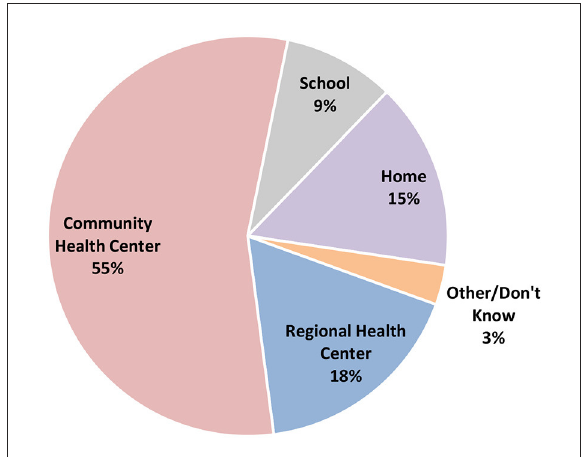
FIGURE6 Preference regarding location of HPV vaccination. Where would you want CC vaccination to take place? This pie chart shows the distribution of preferred locations to vaccinate daughters with HPV vaccine. Most of the participants preferred to vaccinate in the local community